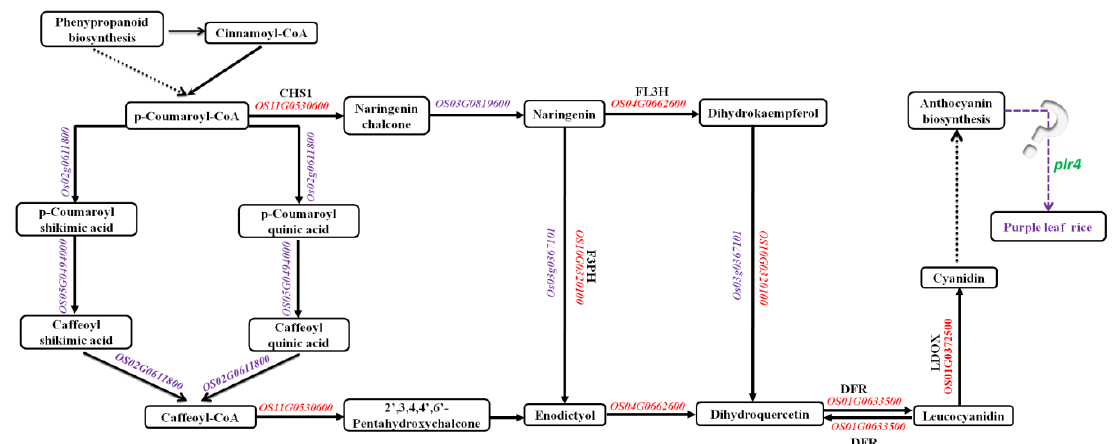
Figure 6. The predicted molecular mechanism of purple leaf formation in rice. Purple is the expression gene, red is the upregulation expression gene, and green is the downregulation expression gene.